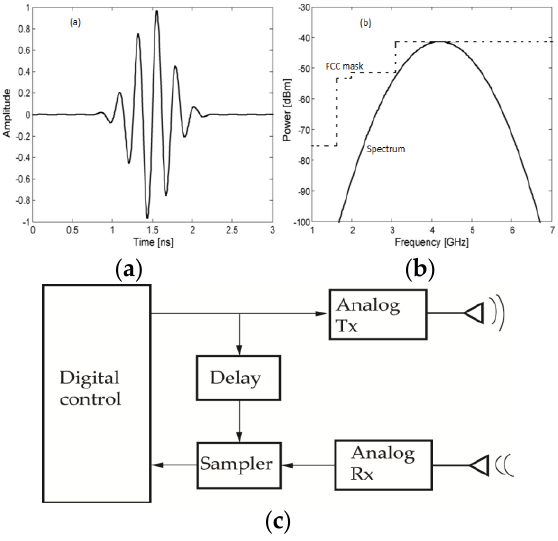
Figure 16. ( a ) Time domain and ( b ) spectrum of an ultra-wideband (UWB) signal; ( c ) basic block diagram of a UWB radar.